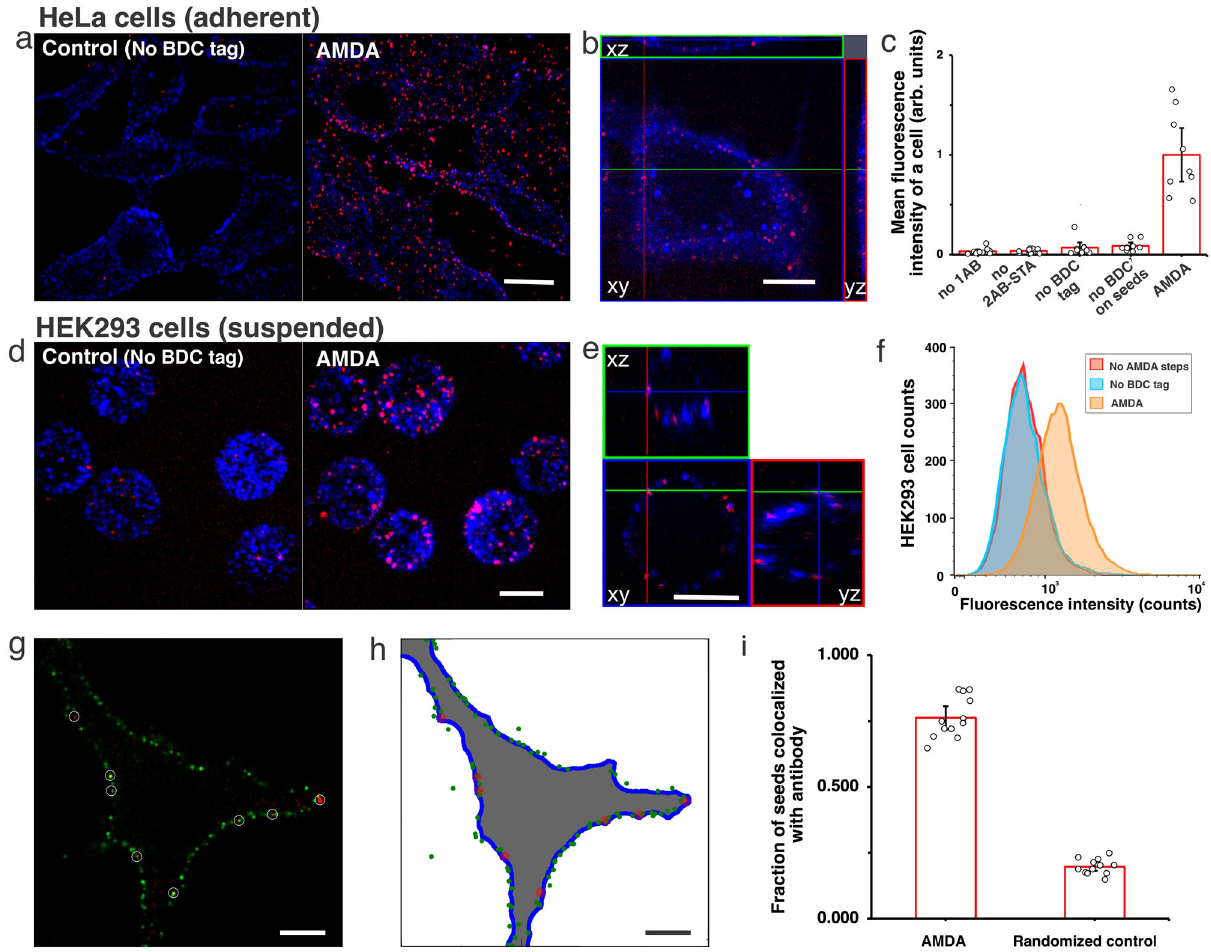
Fig. 2 PEG-coated DNA nanotube seeds attach to EGFR receptors via AMDA. a , d Three-dimensional projection images of HeLa ( a ) and HEK293 ( d ) cells after AMDA or AMDA with BDC tag addition omitted (No BDC tag) to attach seeds to EGFR (Supplementary Notes S20 and S23). Nanotube seeds were labeled with Atto488 (red) and secondary antibody – streptavidin conjugates with Alexa647 (blue). Scale bars: 20 μ m. b Confocal micrograph cross- sections of HeLa cells stained with DiD dye (blue) (Supplementary Note S21) before seeds (red) were attached via AMDA. Scale bar: 20 μ m. This experiment was repeated independently more than three times with similar results. c Average fl uorescence intensities of nanotube seeds per HeLa cell after AMDA or after AMDA omitting different reagents with 32 pM seeded added (Supplementary Note S22, N = 9 random locations for each case were analyzed). For no 1AB: only the addition of EGFR primary antibody was omitted during the AMDA, no 2AB-STA: only the addition of secondary antibody and streptavidin conjugate (2AB-STA) was omitted, no BDC ’ tag on seeds: there were not BDC ’ tags modi fi ed on nanotube seeds. e Confocal micrograph cross-sections of HEK293 cells. Scale bar: 20 μ m. This experiment was repeated independently more than three times with similar results. f HEK293 cell fl uorescence in the channel used to label seeds after AMDA (orange), AMDA with BDC tag addition omitted (blue), and no AMDA (red), measured via fl ow cytometry (Supplementary Note S24). 48 pM seeds were added to cells. Average fl uorescence intensities were 1423 ± 75 ( N = 9818 cells), 883 ± 55 ( N = 9836 cells), and 759 ± 6 ( N = 9867 cells). g – i Co-localization of nanotube seeds and antibodies on the cell membrane (Supplementary Note S25). g Confocal micrograph cross-section of a HeLa cell after AMDA with secondary antibody labeled with Alexa647 (green) and nanotube seeds labeled with atto488 (32 pM) (red). Scale bar: 10 μ m. h Computerized localization of antibodies (green) and seeds (red) of cells in ( g ). i Mean fractions of nanotube seeds colocalized with antibody after AMDA and in randomized controls ( N = 12 cells were analyzed). Error bars here in ( c ), ( f ), and ( i ) are 95% con fi dence measured the mean total angle of nanotube rotation over 30 frames taken every 5 s at different fl uid shear stresses (Supple- mentary Note S41). A maximum time projection image of each nanotube was generated from these images indicating the nanotube ’ s total range of angular motion, Φ (Fig. 4f). The mean Φ for different nanotubes experiencing given shear stress decreased with increasing shear stresses between 0.05 and 2 dyn/cm 2 , which was consistent with our model ’ s predictions (Fig. 4h).